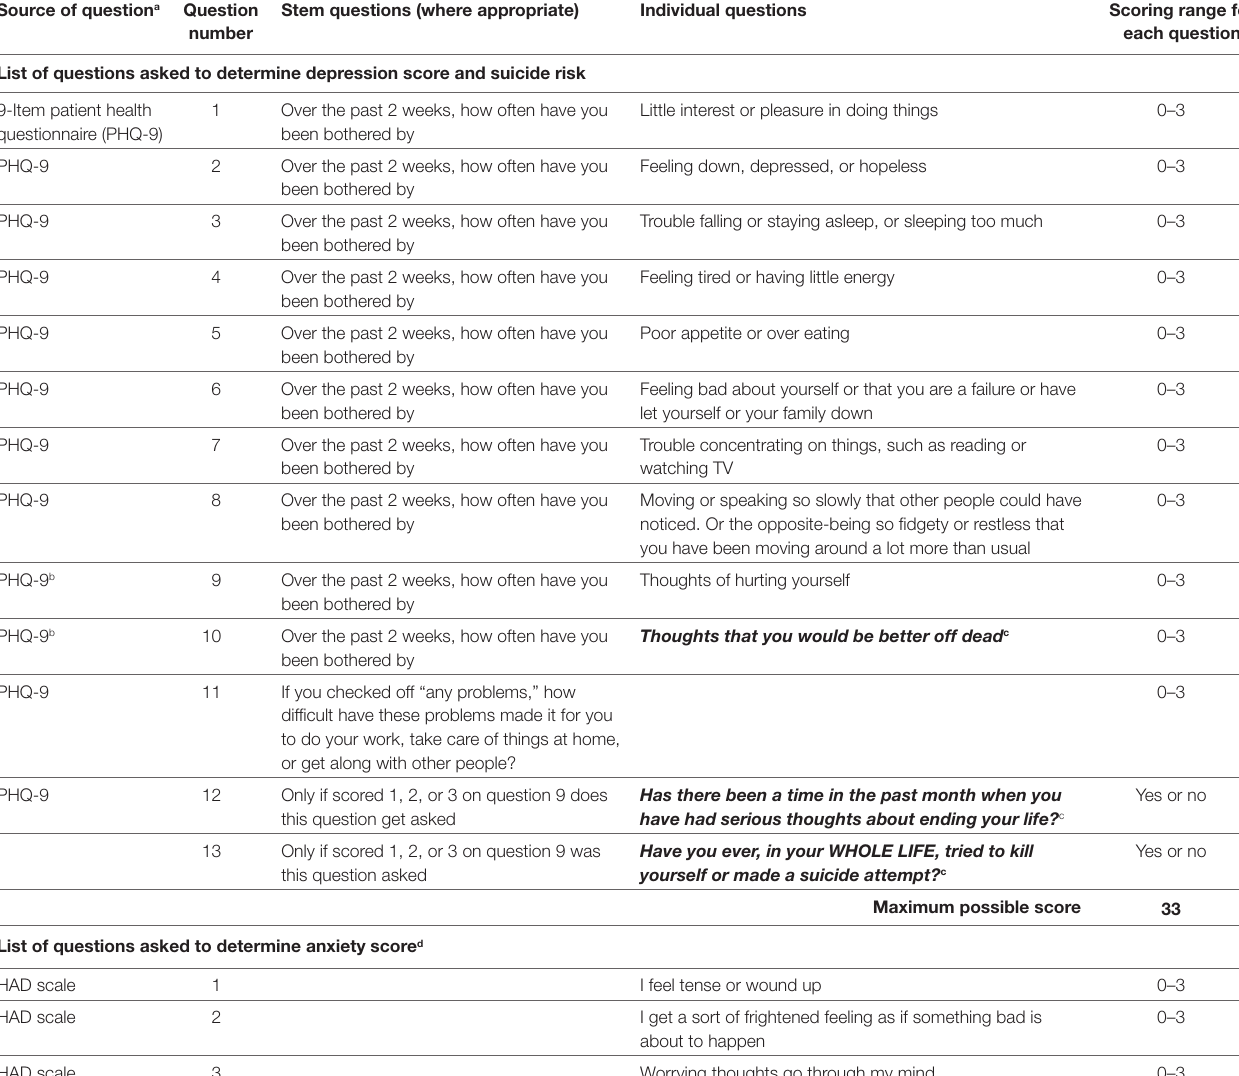
TaBle 2 | list of questions